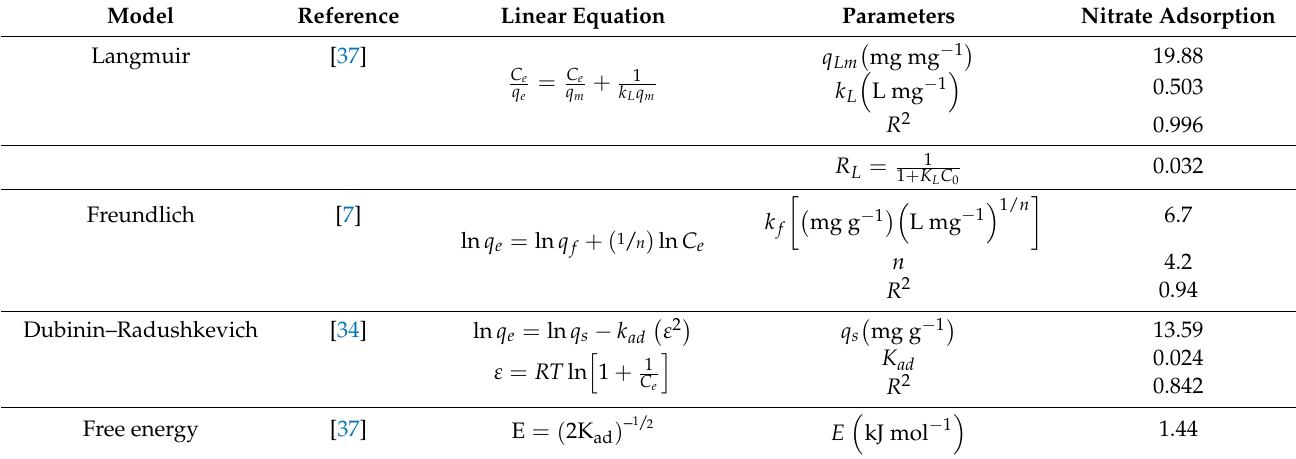
Table 2. Adsorption isotherm models, linear forms, and parameters values for nitrate adsorption using